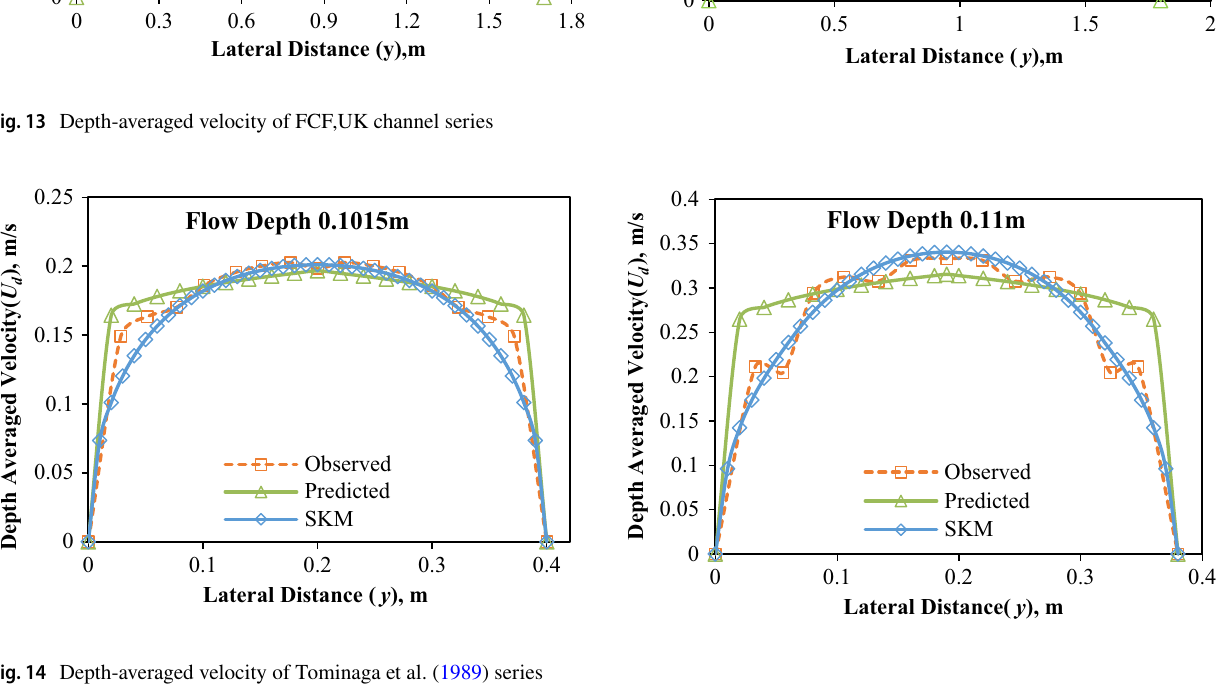
Fig. 14 Depth-averaged velocity of Tominaga et al. (1989)